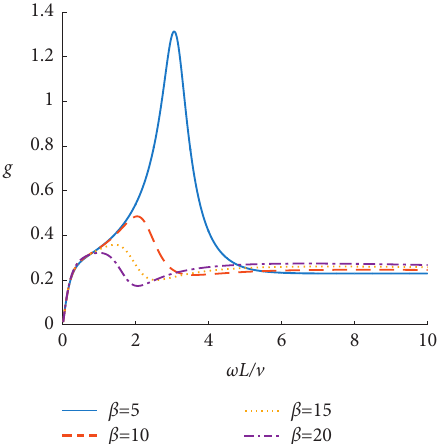
Figure 8: Influence of the parameter β on the equivalent couple amplification factor at the midpoint of the beam.